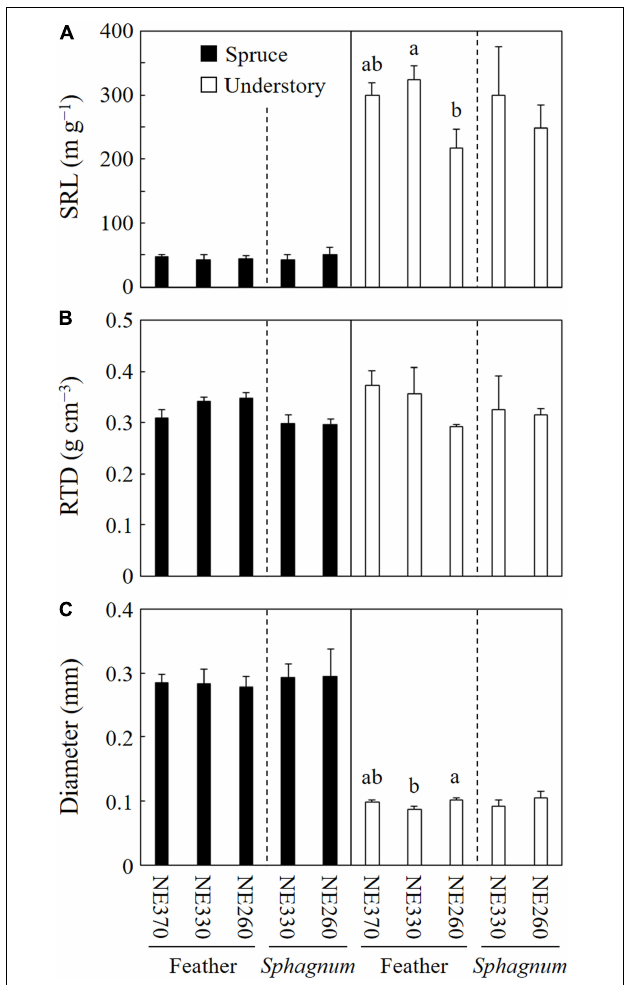
FIGURE 5 | Fine root morphology of black spruce and understory plants in feather or Sphagnum -moss substrates at NE360, NE330, and NE260 plots. Specific root length [SRL, (A) ], root tissue density [RTD, (B) ], and root diameter (C) are shown. Black and white columns represent data on black spruce and understory plants, respectively. Data shown are mean + SE ( N = 4). Different alphabetical letters indicate significant difference between the plots within each species category with each moss substrate (Tukey–Kramer HSD test). No letter was given when significant variation was not detected among the plots by one-way ANOVA.